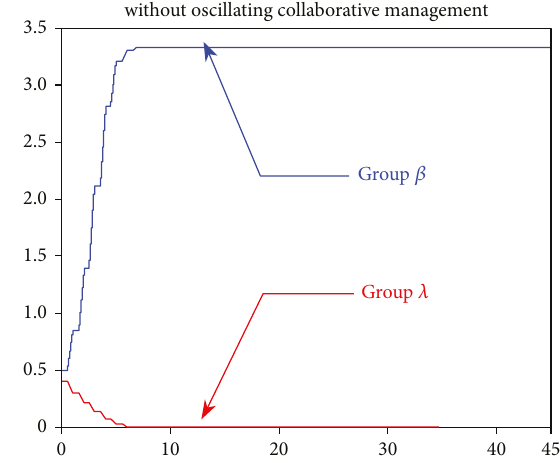
Figure 2: The time-sequence comparison chart of the two groups without oscillating collaborative management.